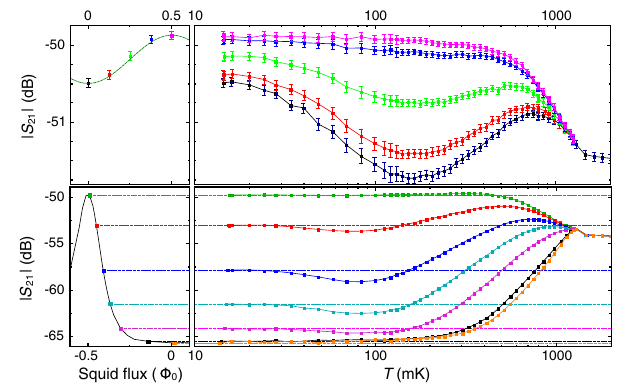
FIG. 3. Measured modulus of the transmission S 21 (as a power ratio) for sample 1 (top panels) and 2 (bottom panels). Left panels: j S 21 j as a function of the flux through the SQUIDs at the base temperature. The modulation is periodic with the flux (data not shown), as usual for a SQUID; only half a period is represented. Note that the position of the zero flux is different in the top and bottom panels. Right panels: j S 21 j for several flux values (using the same colors as on the left panels) as a function of the temperature. For sample 2, the error bars are smaller than the symbols used (note the larger vertical